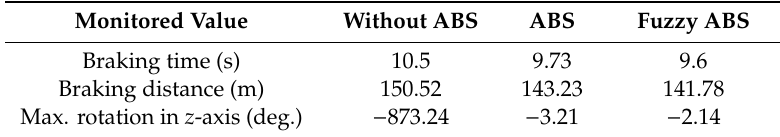
Figure 12. Test on road with combined adhesion at speed 100 km/h—( a ) Speed curve; ( b ) Braking distance; ( c ) Vehicle rotation. Table 5. Test results on road with combined adhesion at speed 100 km/h. Table 5. Test results on road with combined adhesion at speed 100 km / h.